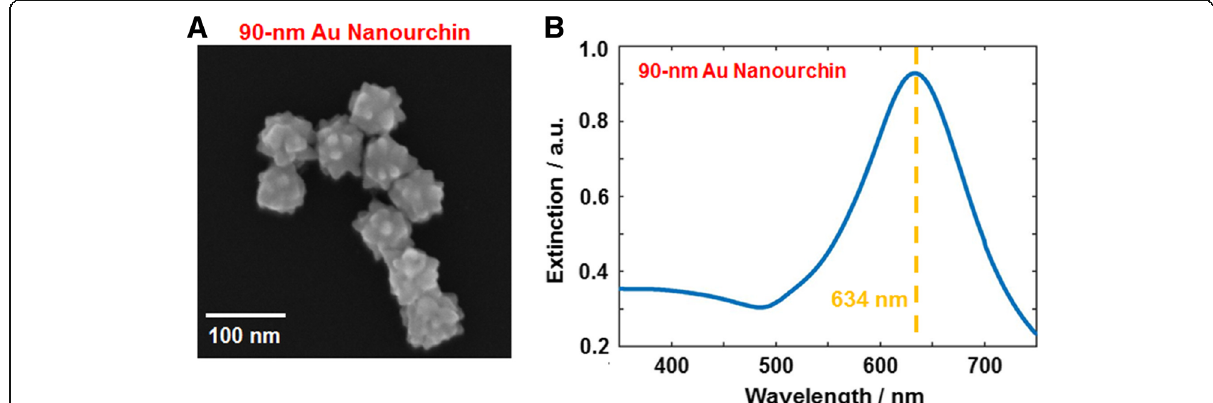
Fig. 1 a SEM image of 90 nm AuNUs with sharp and short branches. b UV-Vis absorption spectrum of 90 nm AuNUs dispersed in water. A single broad peak is observed at approximately 634 nm indicated by the yellow-dotted line